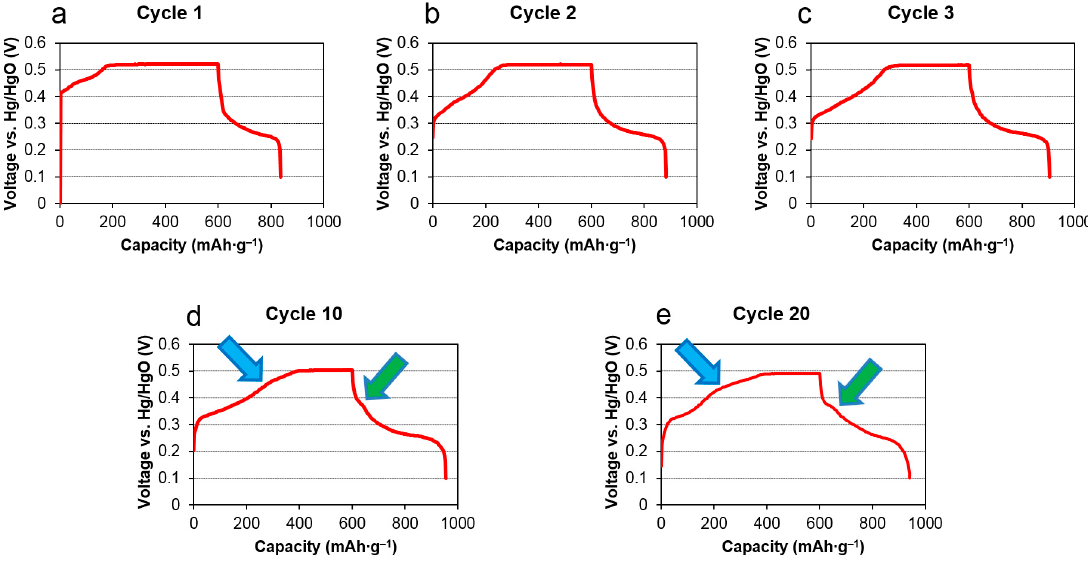
Figure 4. Half-cell voltage profiles of WM12 at ( a ) cycle 1, ( b ) cycle 2, ( c ) cycle 3, ( d ) cycle 10, and ( e ) cycle 20. The blue and greens arrows point to the α -to- γ and γ -to- α transitions, respectively.